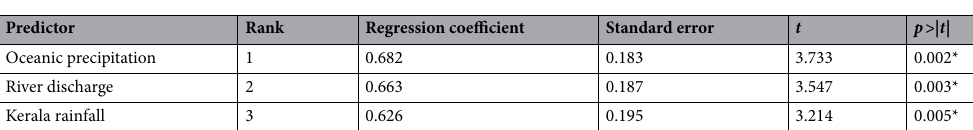
Table 1. Multiple linear regression analysis with de-trended D 24 as the predictand and parameters such as oceanic precipitation, river discharge, and Kerala rainfall as predictors for the period 2001–2019. *Denotes the values that are statistically significant at p <